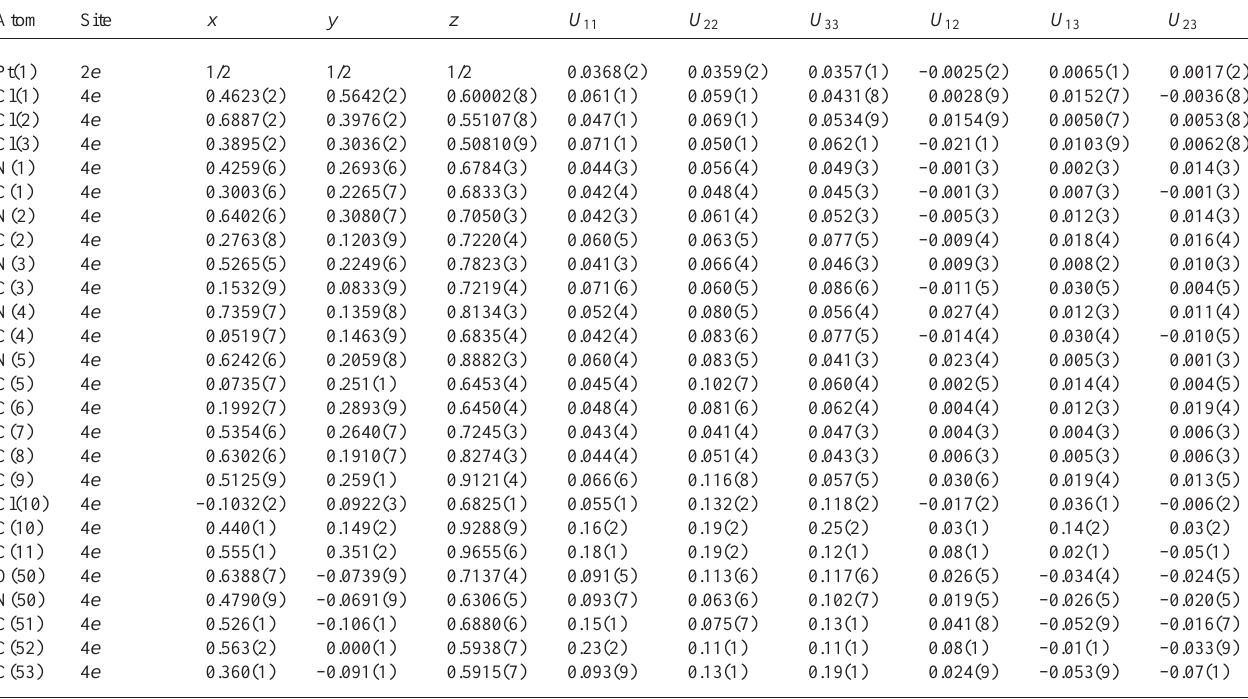
Table 6. Atomic coordinates and displacement parameters (in Å 2 ) .